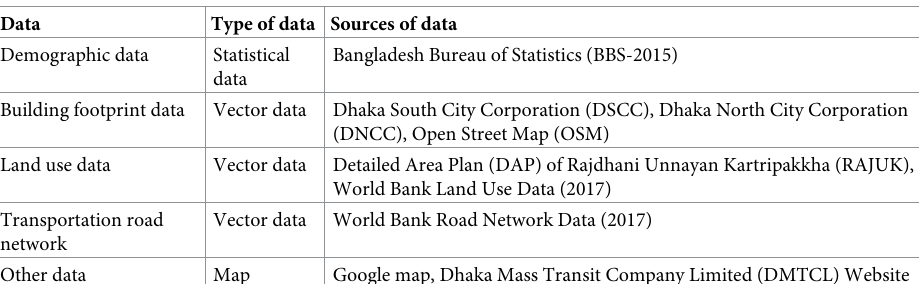
Table 2. Sources of